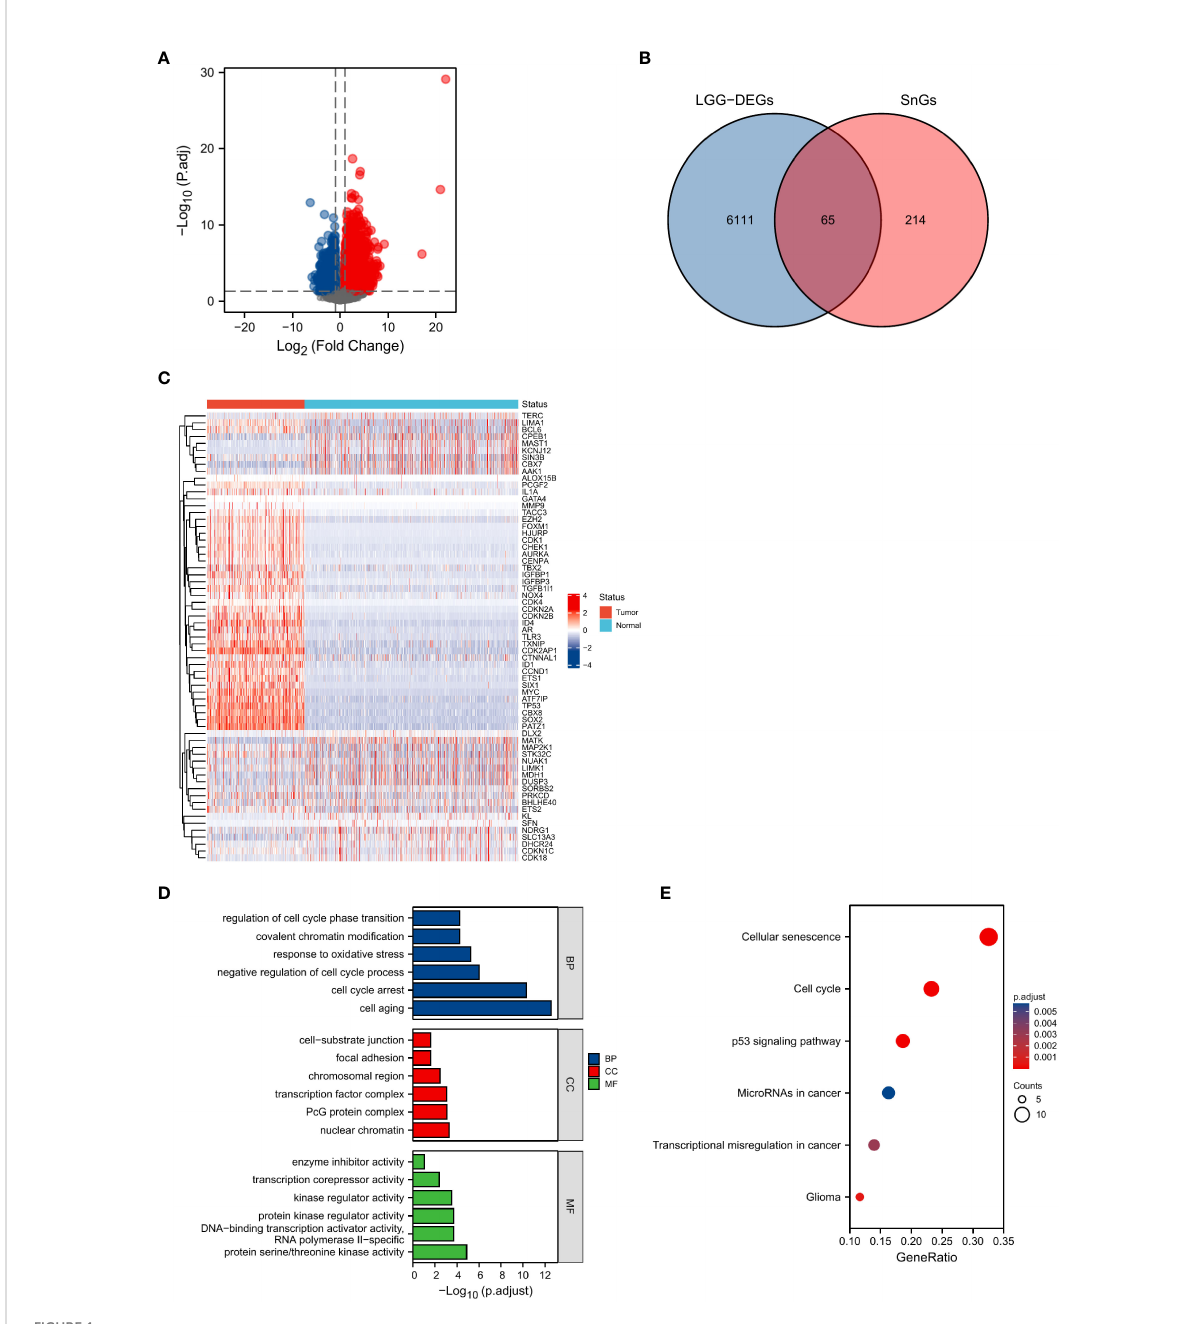
FIGURE 1 Identi fi cation and functional enrichment analyses of senescence-related DEGs. (A) Identi fi cation of DEGs between normal and LGG samples. (B) Intersections of DEGs and SnGs by Venn diagram. (C) Heatmap of the expression levels of the 65 senescence-related DEGs. (D) GO enrichment analyses. (E) KEGG analysis